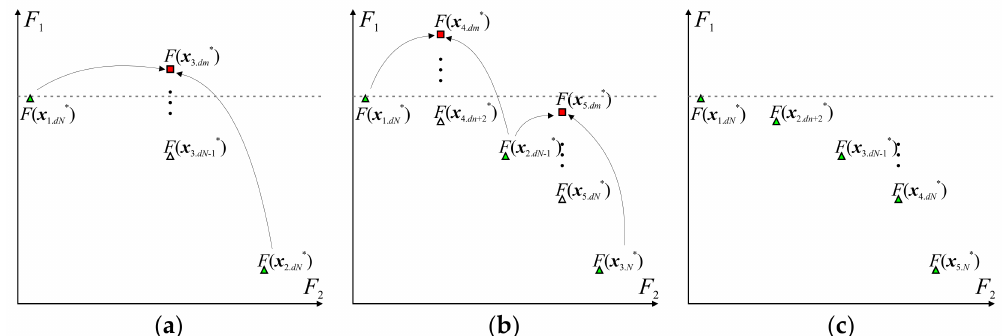
Figure 5. Generation of the optimal designs between the existing solutions for K = 2, where: ( a ) k = 1 (before reindexing), ( b ) k = K (before reindexing), and ( c ) k = K (after reindexing). Note that the candidate designs (red squares) are obtained through approximation of the geometries optimized in previous iterations using d m dimensions. The white and green triangles represent the optimized designs before and after reindexing, respectively. The final designs can be represented using a varying number of